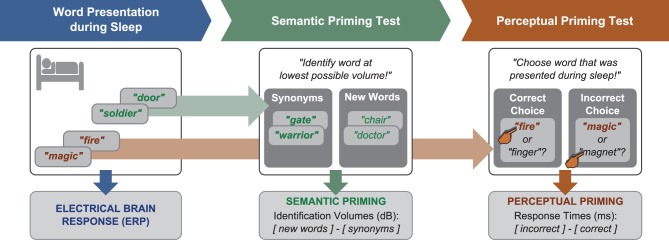
Design. Word presentation during sleep was followed by two priming tests. In the semantic test, identification volumes for synonyms to sleep-played words and new words were contrasted. In the perceptual test, response latencies for correct and incorrect responses in a two-alternative forced-choice recognition test for sleep-played words were compared.